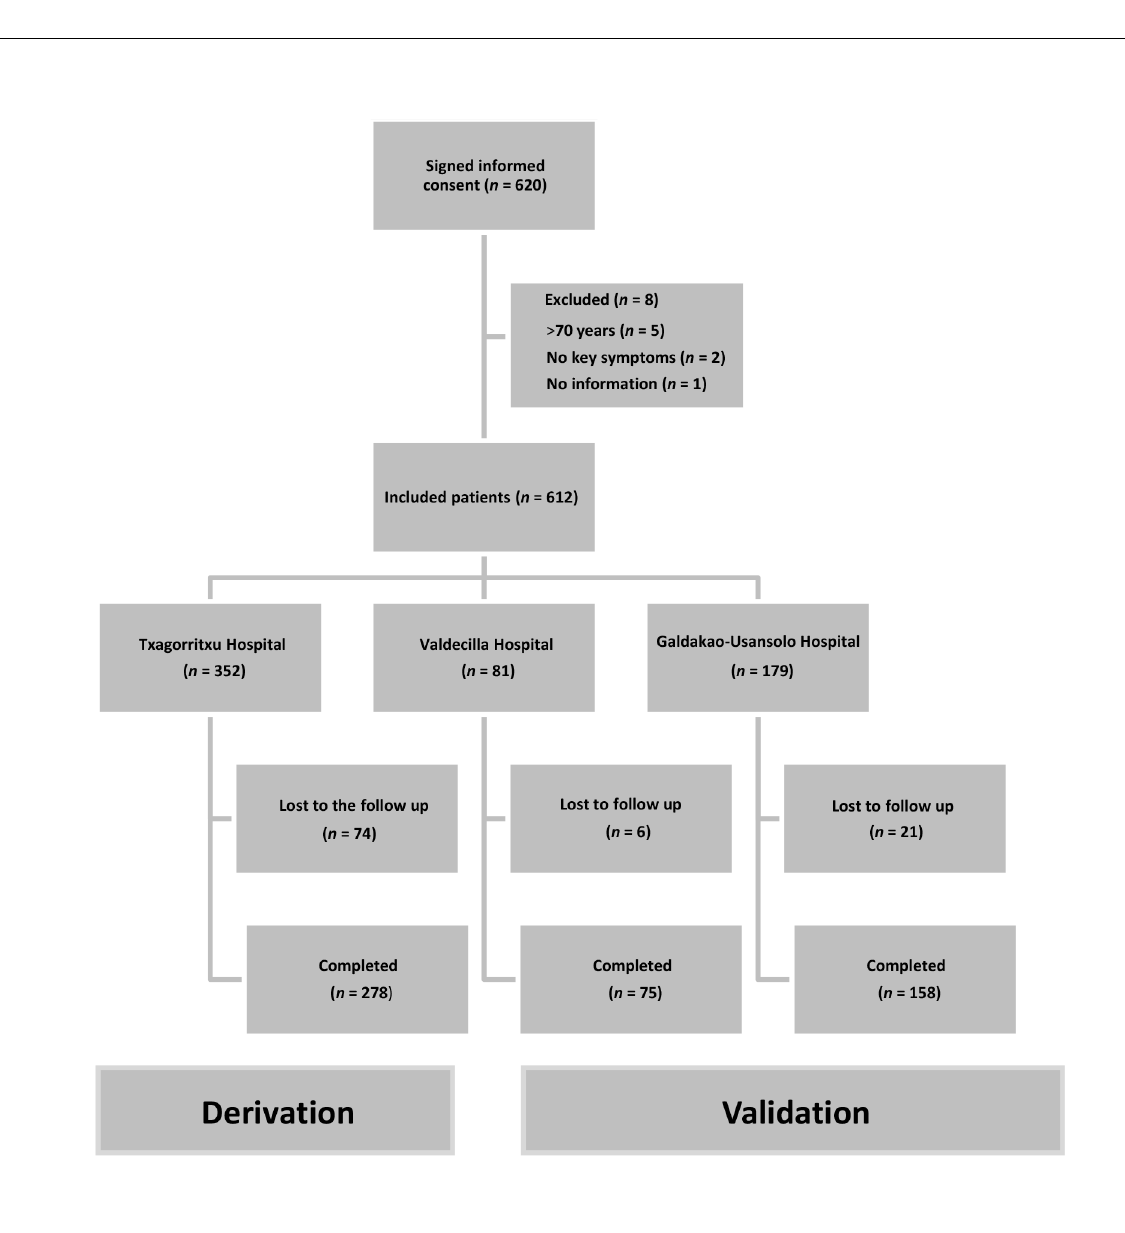
Figure 1. Flow chart of inclusion and exclusion criteria